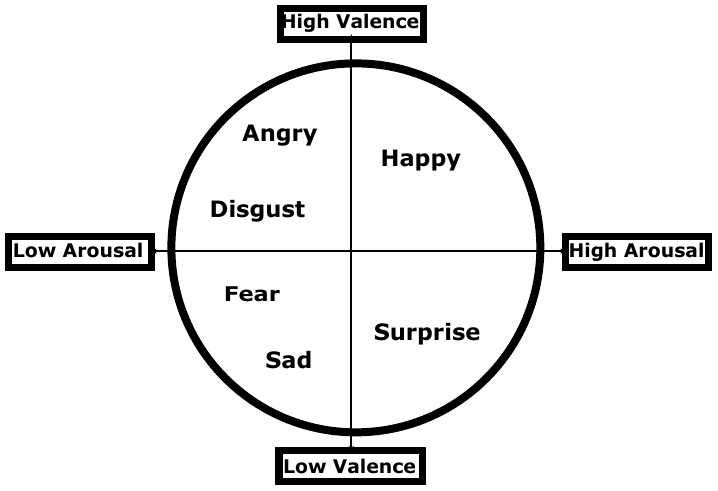
Figure 1. Valence arousal model for emotion